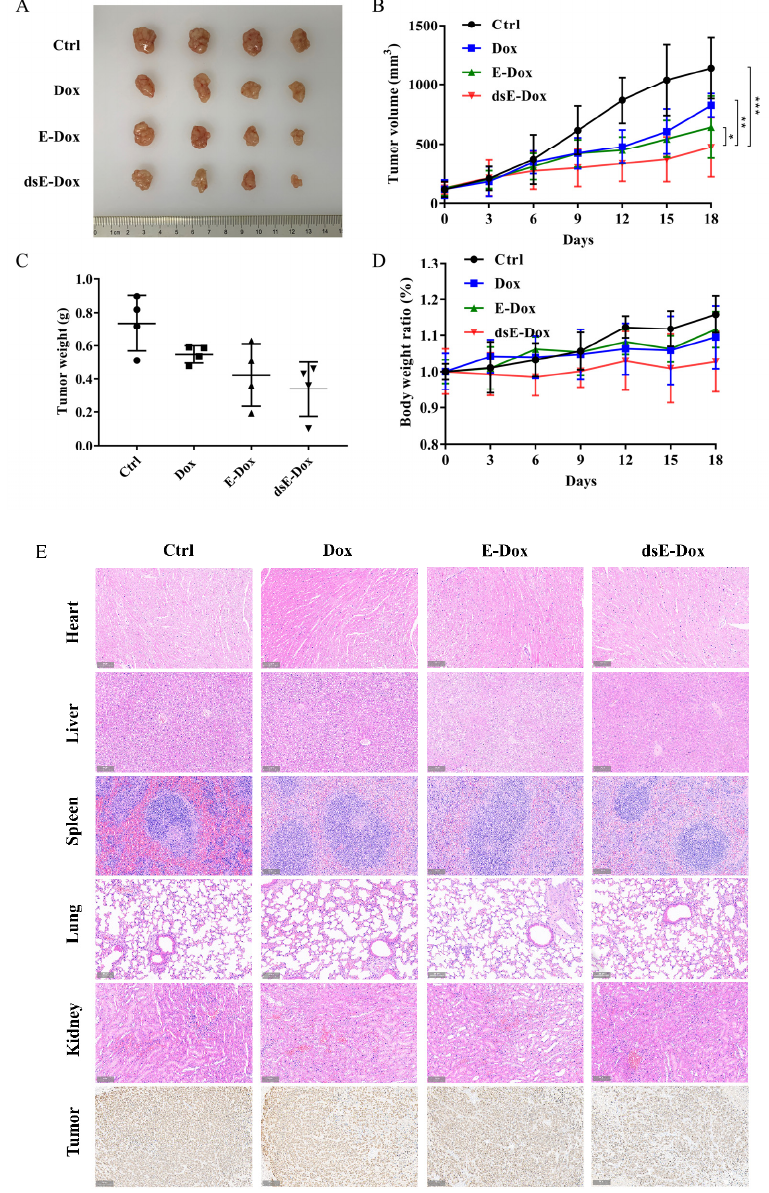
Figure 6. The in vivo antitumor activity of dsE-Dox. ( A ) HepG2 tumor-bearing mice treated with PBS, Dox, E-Dox, or dsE-Dox (equal to 2 mg/kg Dox) every 3 days via the tail vein. The tumor was isolated and photographed. ( B ) The tumor growth curves (n = 4, mean ± SD). ( C ) The weight of the excised tumor. ( D ) The body weight ratio. ( E ) H&E staining of the heart, liver, spleen, lungs, and kidney. Ki67 staining of the tumor tissues. Scale bar, 100 µ m. The data were presented as the mean values ± SD. * p < 0.05, ** p < 0.01, *** p <